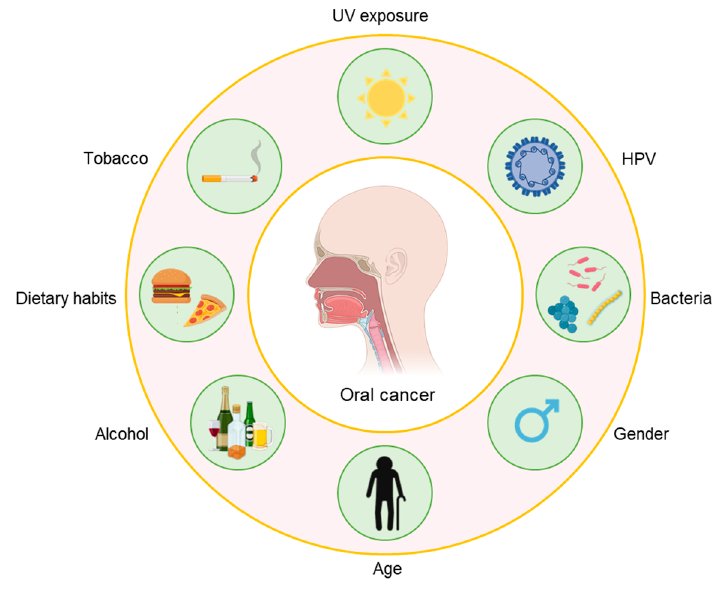
Figure 1. Oral cancer risk factors.